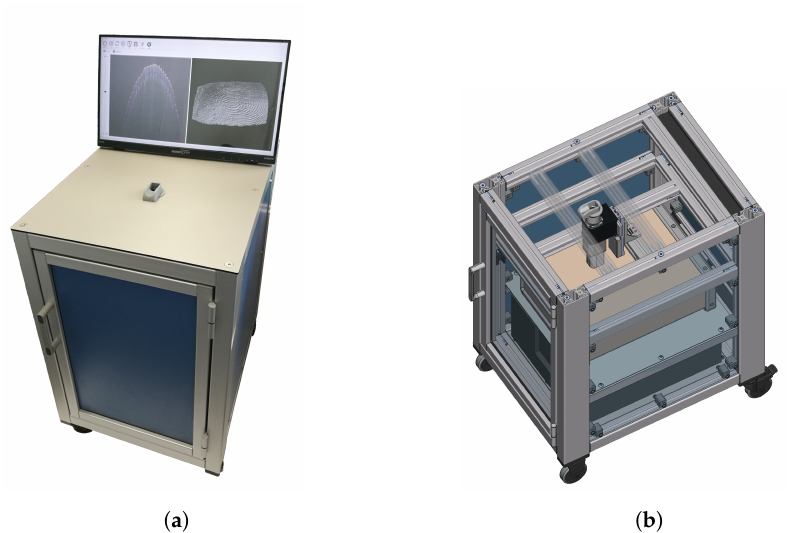
Figure 3. OCT container setup. ( a ) Running our measurement and processing software. ( b ) CAD model showing the scan head mounted to a linear